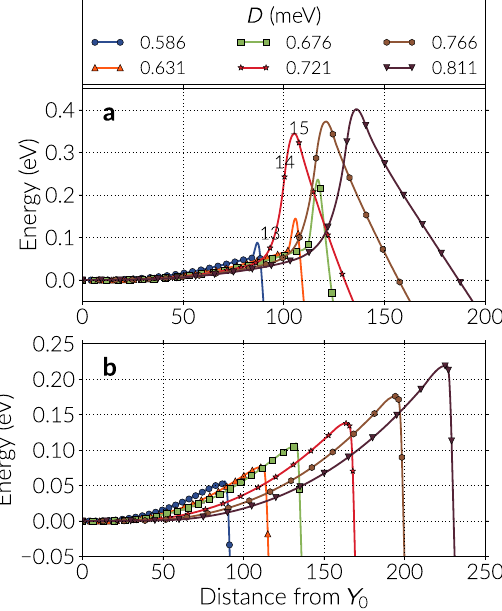
Figure 6. Energy bands for two skyrmion destruction mechanisms. The bands are shown for different DMI constant D and only for the first few images of the bands. The first or extreme left image is the skyrmion configuration and for every case, the energy is redefined with respect to the skyrmion energy. The continuous line is a cubic polynomial interpolation. ( a ) The energy bands obtained with the NEBM. The curves for DMI values of D = 0.676 meV and below, are the skyrmion collapse. For values of D = 0.721 meV and above, the bands are the skyrmion destroyed by a Bloch point like singularity. ( b ) Refined energy bands obtained with the Climbing Image NEBM applied to the largest energy points of the curves in Figure ( a ). We expect the data in ( b ) to be a better approximation of the energy barrier. For this case, all the bands converged towards the skyrmion collapse